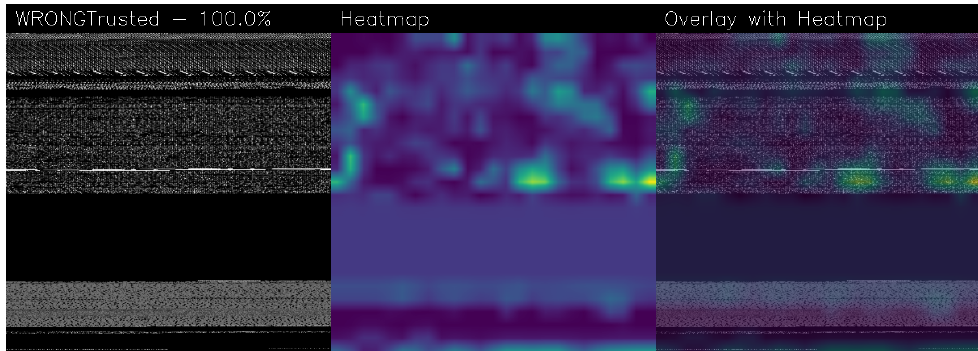
Figure 11. The wrong classification of sample Dowgin